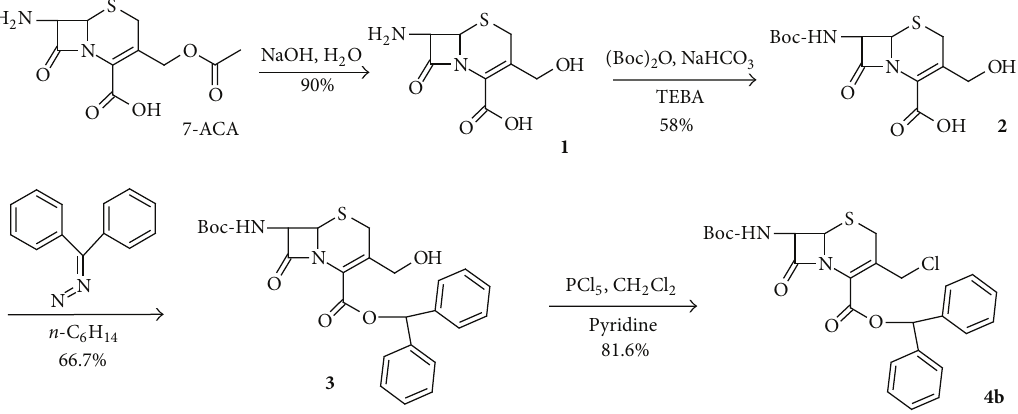
Scheme 1: Synthetic route of Boc-ACLH.